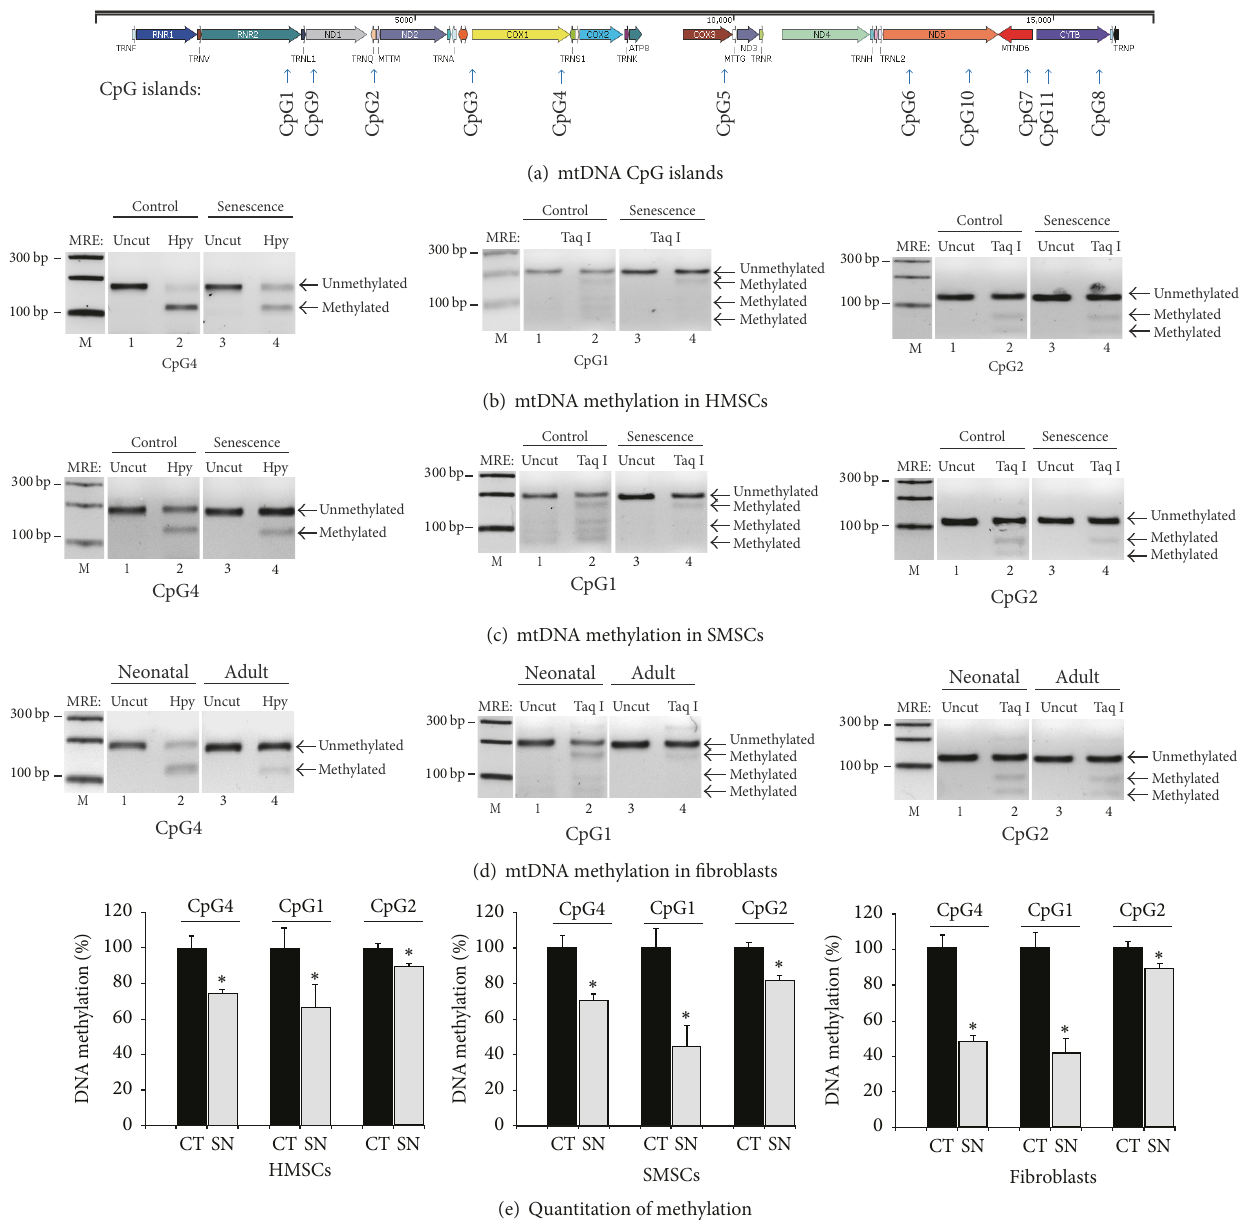
Figure 3: Altered mtDNAmethylation in senescent MSCs. (a) Schematic diagram of themitochondrial genes and thelocation of CpG islands. In order to detect mtDNA methylation in senescent cells, we designed 11 pairs of methylation-specific primers located on different genes on mitochondrion. (b) Comparison of mtDNA methylation between the control and senescent HMSCs. mtDNA methylation was measured by combined bisulfite restriction analysis (COBRA). PCR products from mtDNA of control and senescent HMSCs were digested by TaqI or HpyCH4IV (HPY) to separate the unmethylated and methylated DNAs. Taq I and HpyCH4IV recognize and digest the methylated ACGT and TCGA sites, respectively. After treatment with sodium bisulfate, unmethylated cytosines were converted to uracils, and the TTGA and ATGT sites are not digested by these two enzymes. After digestion, unmethylated and methylated DNA were separated on 3% agarose gels. Only the data for CpG islands 4, 2, and 1 are presented here. (c) Differential mtDNA methylation between the control and senescent SMSCs. (d) Altered mtDNA methylation in human neonatal and adult fibroblasts. (e) Quantitation of mtDNA CpG methylation. The methylated and unmethylated bands were scanned. The status of CpG methylation was calculated as the relative percentage of DNA methylation using the untreated MSCs as 100. ∗ 𝑃 < 0.05 as compared with that in untreated MSC control cells. Note the decrease in mtDNA methylation in senescent